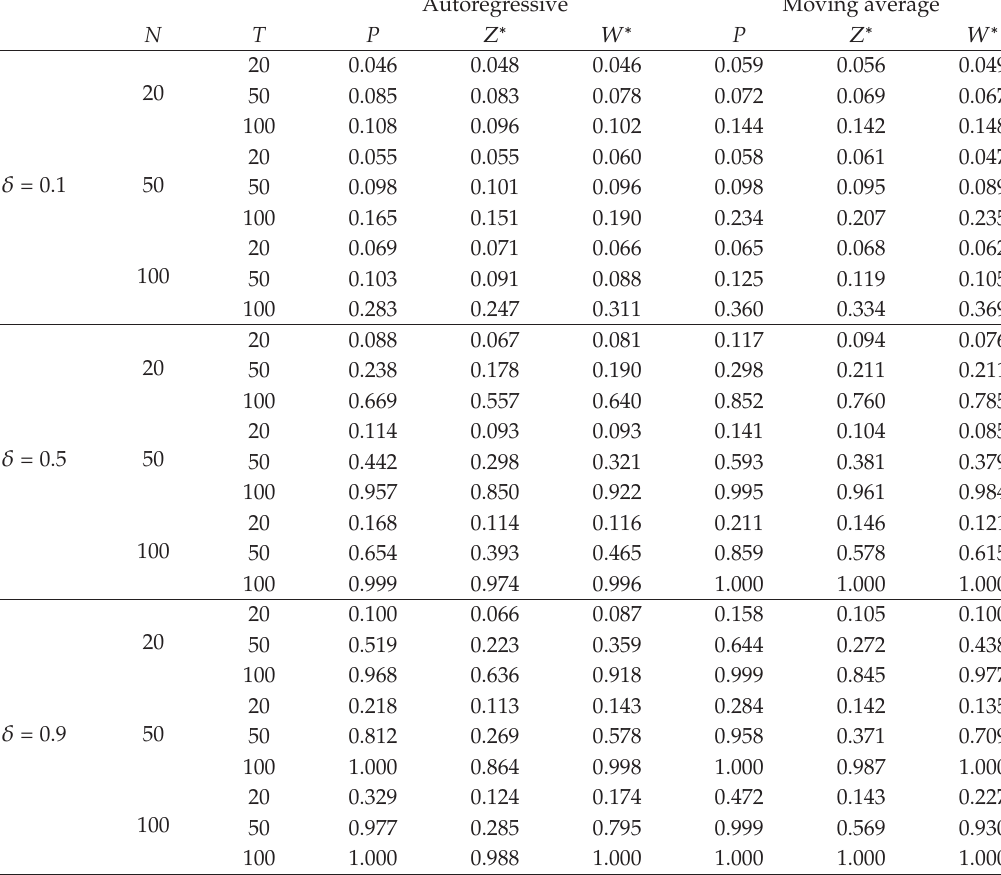
Table 7: Size-adjusted power of panel unit root tests: intercept only, spatial dependence. Autoregressive Moving